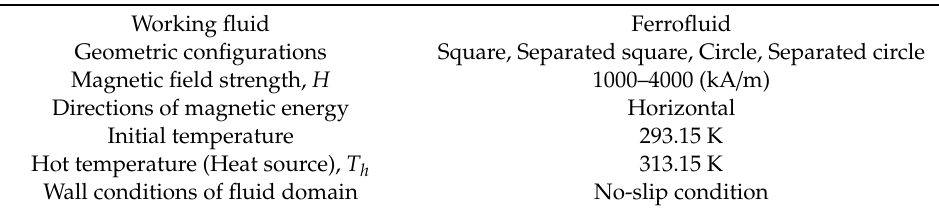
Table 2. Boundary conditions applied in this study.